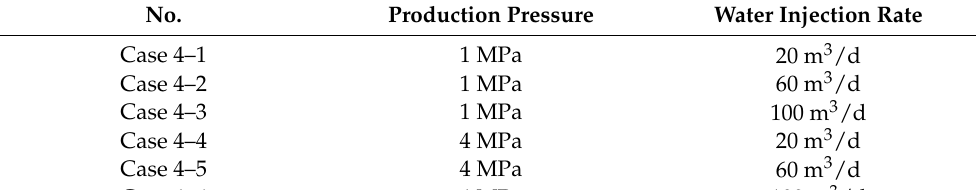
Table 6. Main production parameters for the depressurization combined thermal stimulation cases.